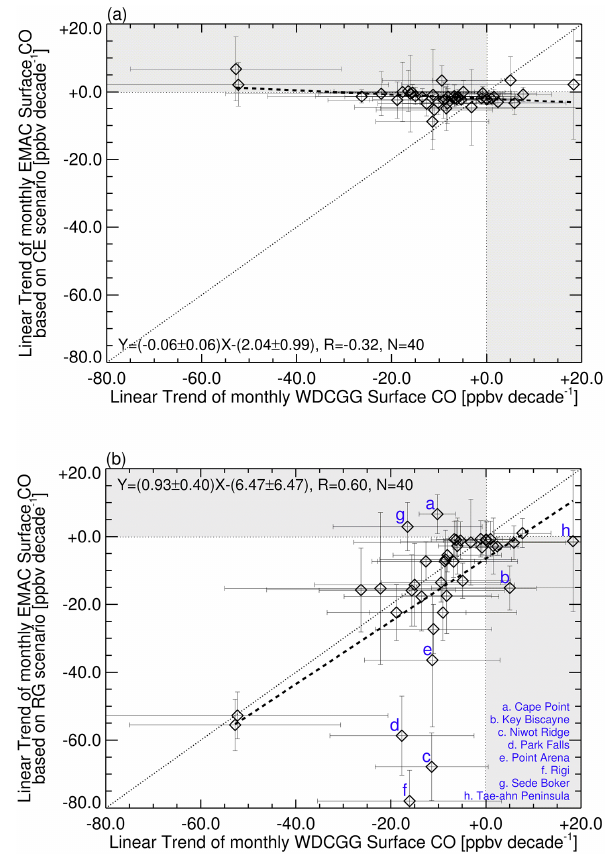
Figure 6. Comparisons of the trends of monthly EMAC-simulated surface CO based on (a) CE and (b) RG scenarios with the trend of monthly WDCGG-archived surface CO (with ± 2 σ errors for se- lected WDCGG stations listed on Table 2). In particular in Fig. 6b, some stations (i.e., Cape Point, Key Biscayne, Niwot Ridge, Park Falls, Point Arena, Rigi, Sede Boker, and Tae-ahn Peninsula influ- enced by local pollution or transports) are selected as outliers and are indicated by blue fonts. Detailed values are summarized in Ta- ble 4.